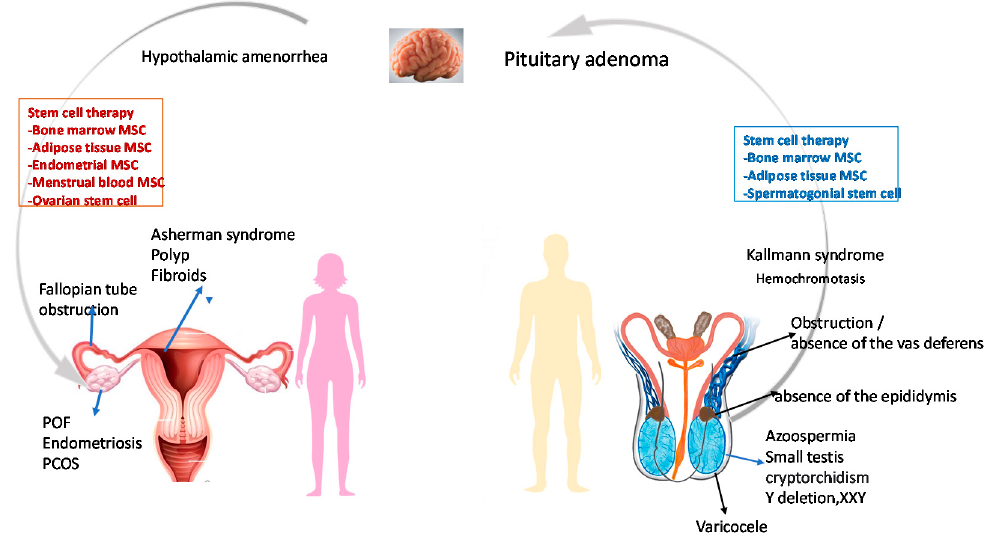
Figure 1. Some probable causes of infertility in male and female. POF: premature ovarian failure, PCOS: Polycystic ovarian syndrome, XXY: Klinefelter syndrome, MSC: Mesenchymal stem cell. Modified from references Lindsay and Virtikas [8] and Zhao et al. [11].